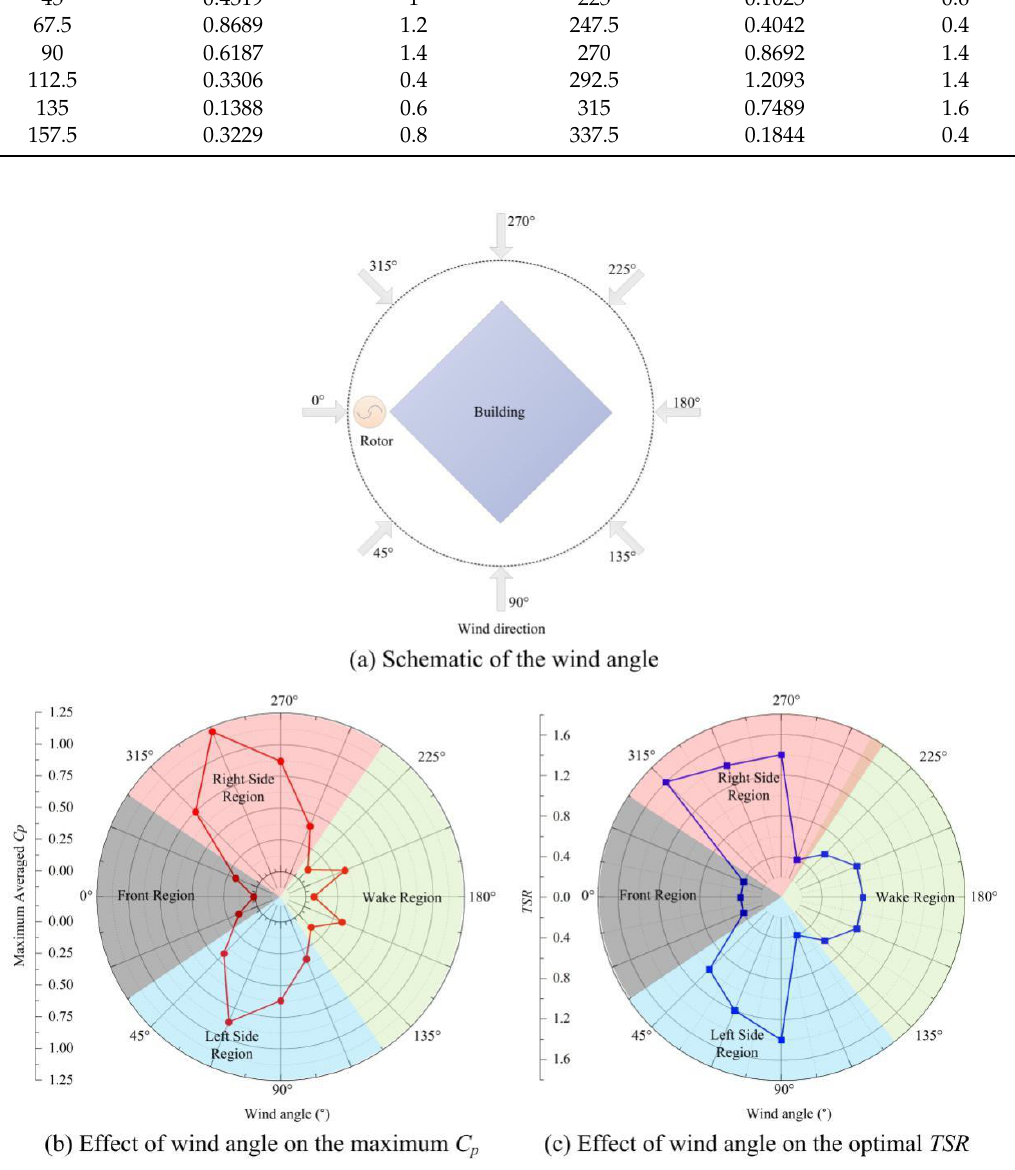
Figure 17. Plots of the maximum C p and the optimal TSR with respect to the wind angle.